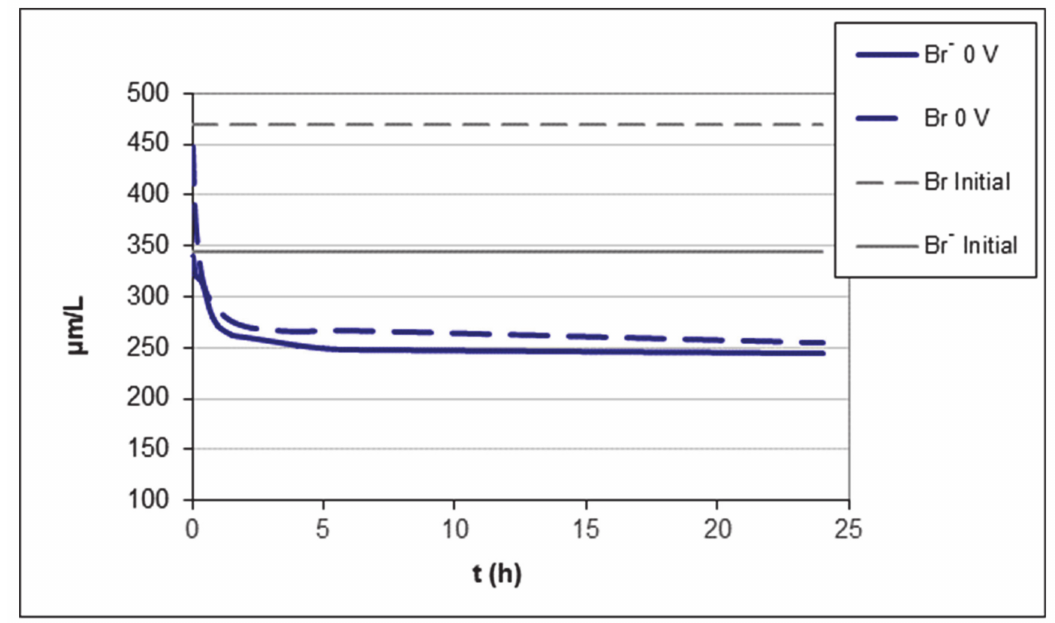
Figure 2. Variation of bromide and total bromine concentration in the absence of voltage. Filter press.